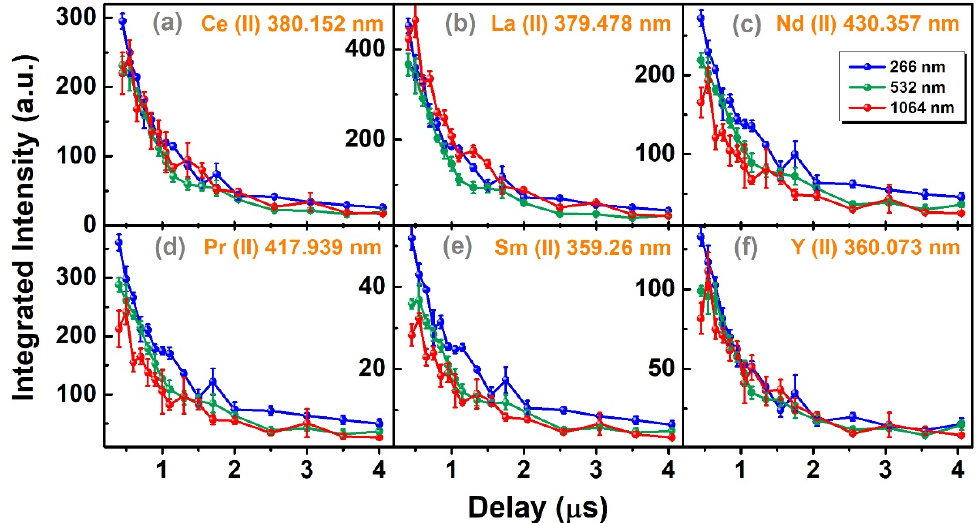
Figure 7. Temporal decay of 6 REE emission lines from 0.4 µs to 4.0 µs.